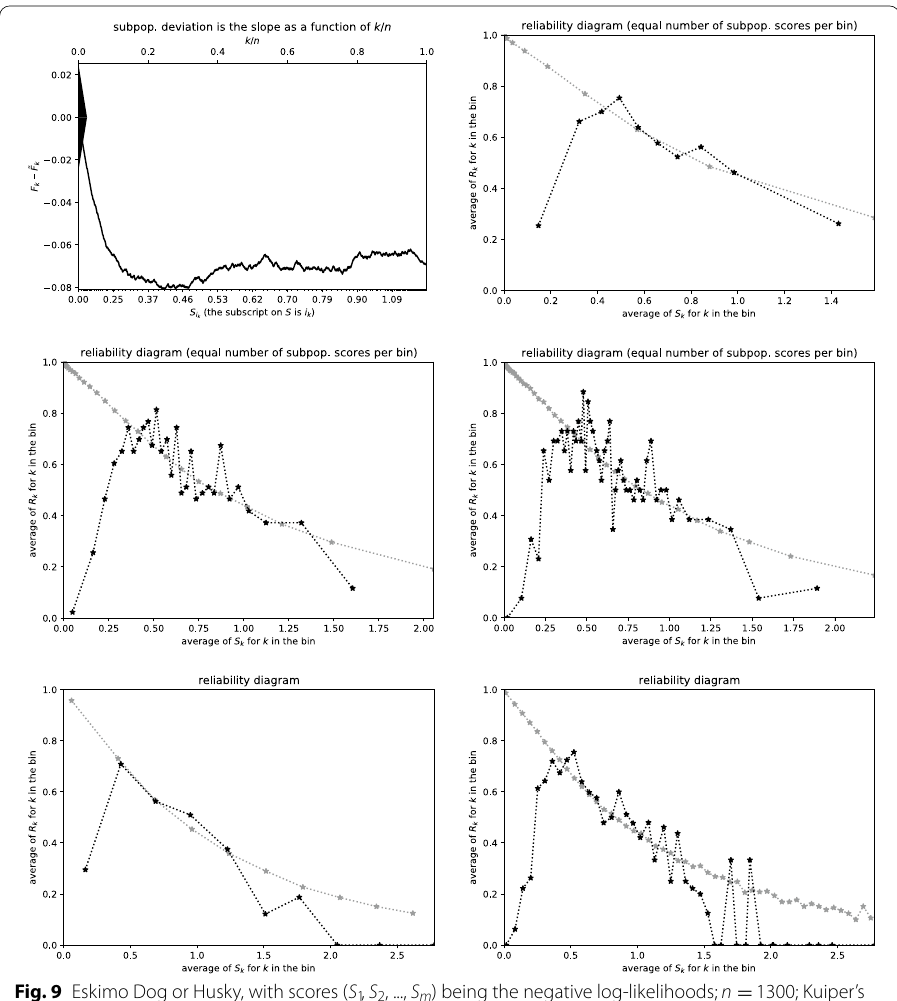
Fig. 9 Eskimo Dog or Husky, with scores ( S 1 , S 2 , ..., S m ) being the negative log-likelihoods; n = 1300; Kuiper’s statistic is 0.08082 /σ = 6.363 , Kolmogorov’s and Smirnov’s is 0.08082 /σ = 6.363 . None of the reliability diagrams is able to smooth away the irrelevant variations while simultaneously capturing the severe deviation at the lowest negative log-likelihoods. The scalar summary statistics very successfully detect the statistically highly significant deviation of the subpopulation from the full